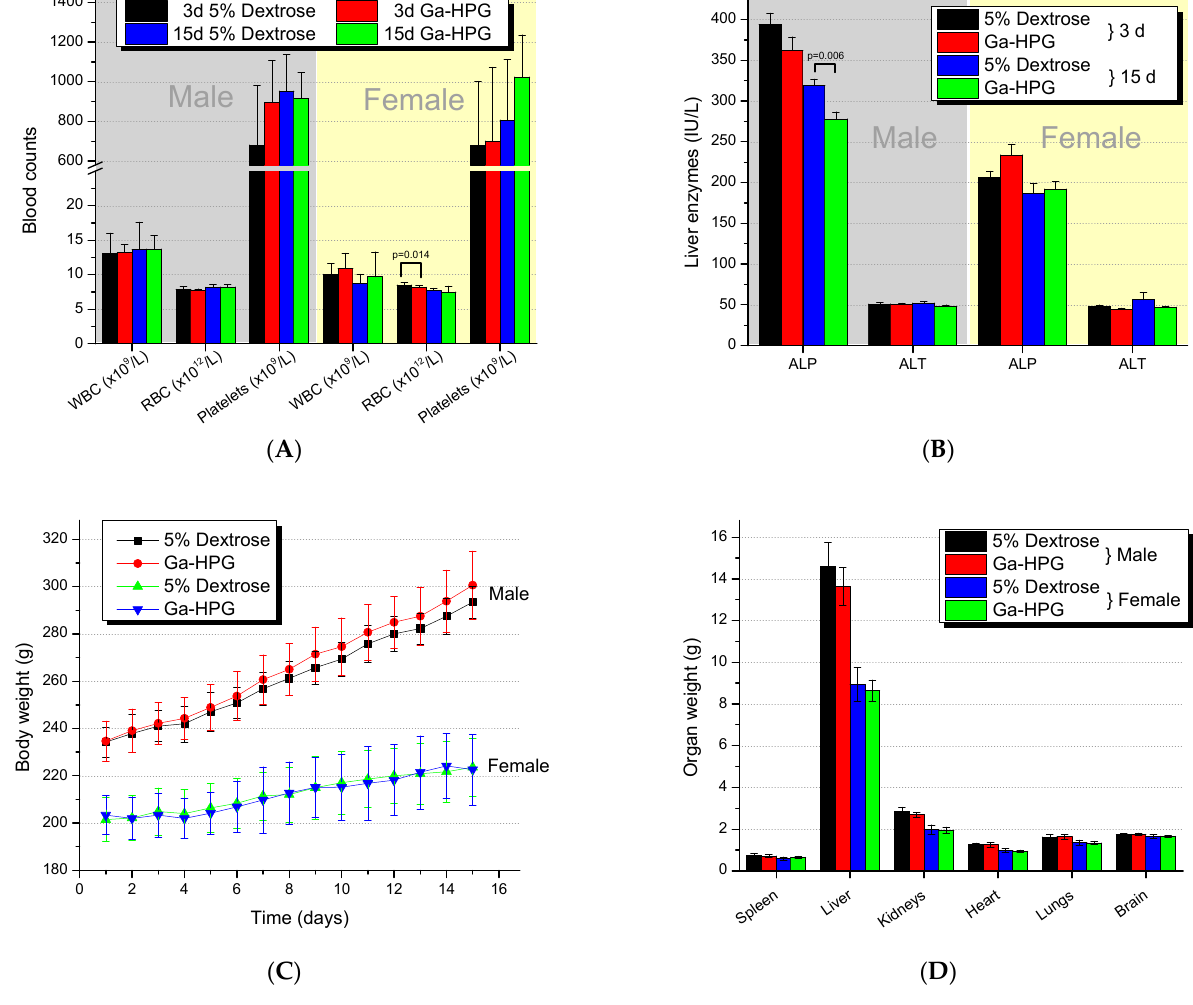
Figure 5. ( A ) Blood counts and ( B ) liver enzyme levels in male and female Sprague Dawley rats 3 and 15 days after application of Ga-HPG at 150x the amount given during the imaging ( n = 10 per group and sex). ( C ) Body weight over time. ( D ) Organ weight at time of euthanasia (day 15) in male and female Sprague Dawley rats after application of Ga-HPG at 150× the amount given during the imaging ( n = 10 per group and sex).